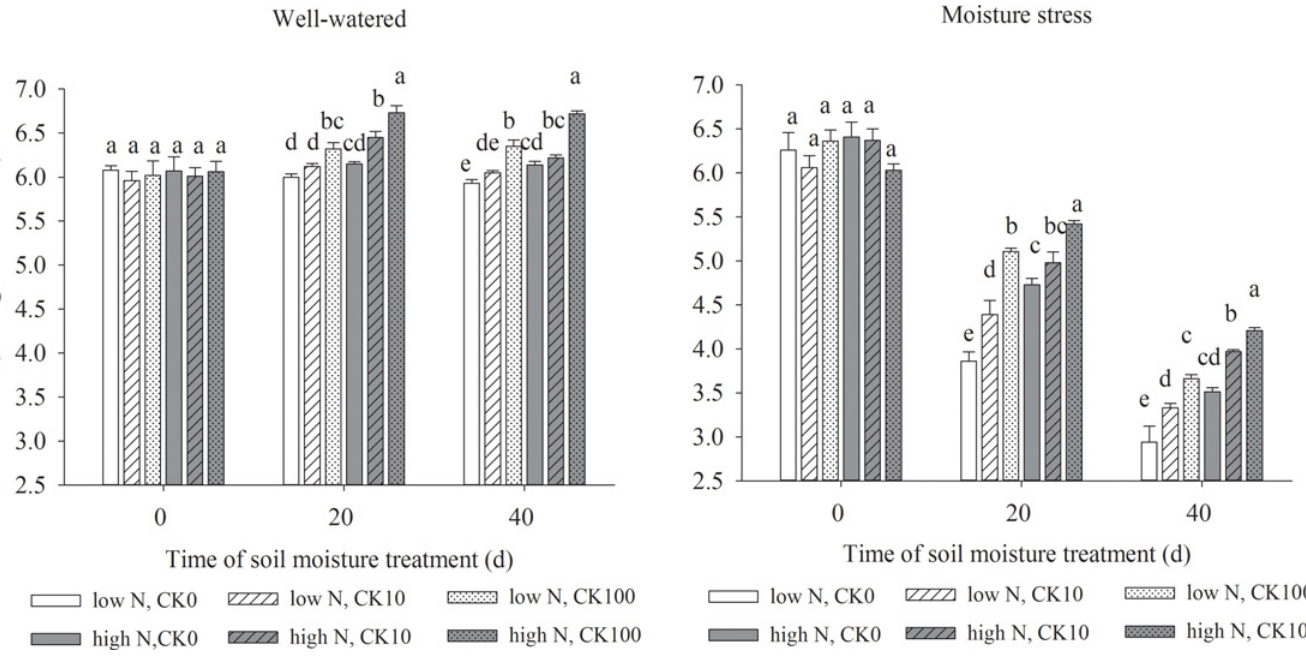
PLOS ONE | DOI:10.1371/journal.pone.0154005 April 21, 2016 10 /